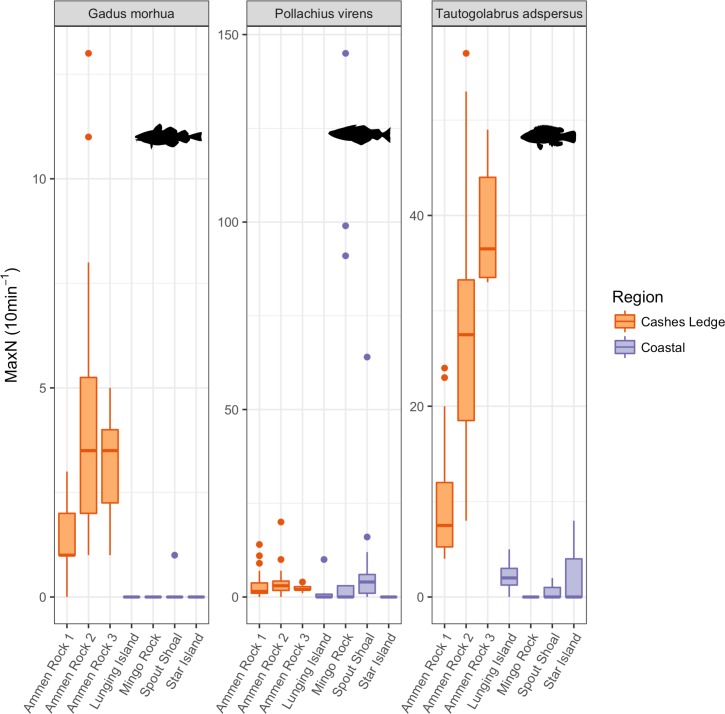
Abundance (maximum number of individuals observed in a single frame–MaxN–during a 10-minute segment) of the three fish species observed in stationary video deployments.Data are compiled for all years (2014–2016) to facilitate coastal to Cashes Ledge comparisons. Boxplots as in Fig 3. Note different scales on y-axes.